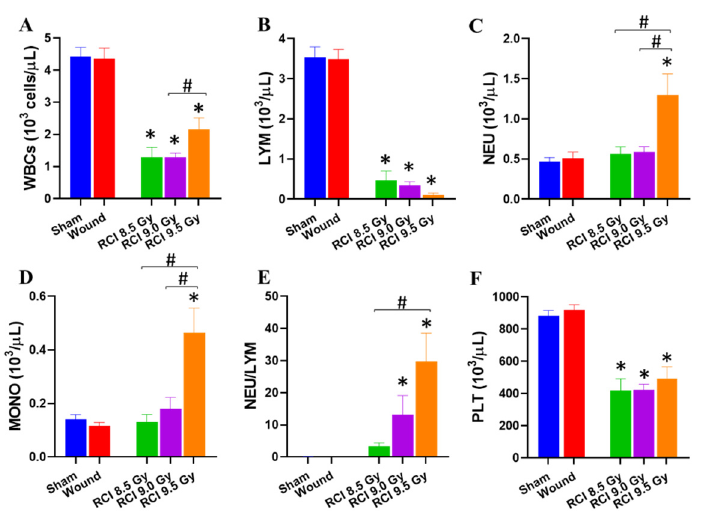
Figure 2. Neutrophil (NEU), monocyte (MONO), and neutrophil/lymphocyte ratios (NEU/LYM) are elevated and LYM and platelets are declined in lethal doses of RCI mice. ( A , B , F ) White blood cells (WBCs), lymphocytes (LYM), and platelets (PLT) were significantly decreased in all RCI groups. However, neutrophils (NEU) and monocytes (MONO) were significantly elevated in 9.5 Gy RCI ( C , D ). The NEU/LYM ratio was significantly elevated in 9.0/9.5 Gy RCI ( E ). * p < 0.05 for RCI vs. sham by one-way ANOVA and Dunnett’s multiple comparisons test; # p < 0.05 for comparison among three RCI groups by one-way ANOVA and Tukey’s multiple comparisons test; N =